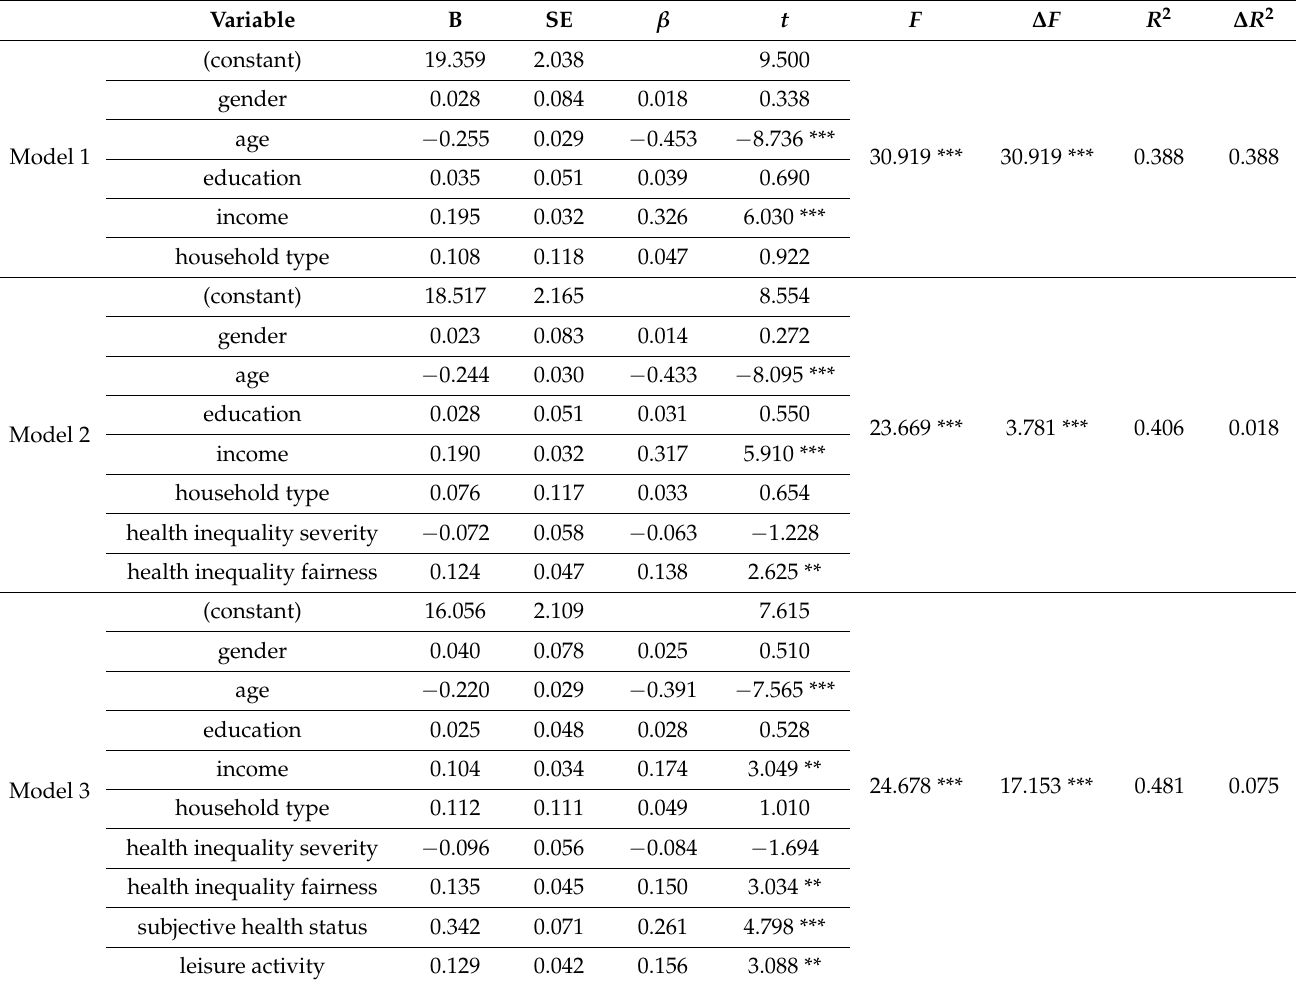
Table 6. Hierarchical Regression Analysis on Quality of